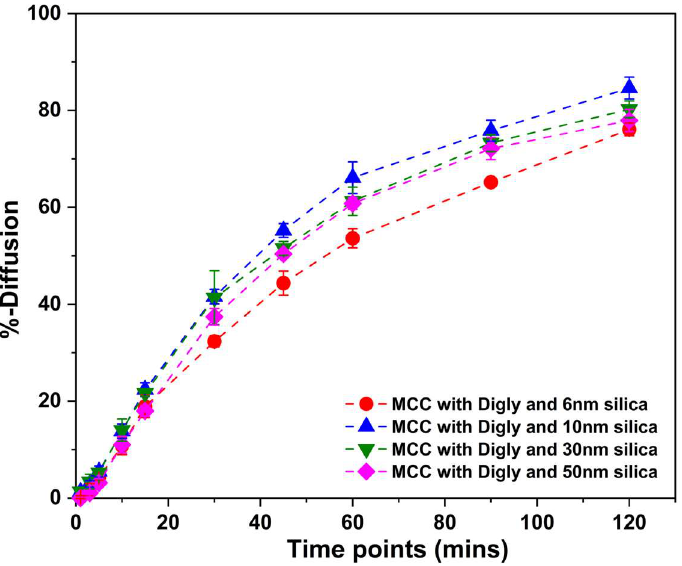
Figure 4. %diffusion of diglycine from the diglycine, silica, and MCC composite tablet compressed at 2.5 kN. The diffusion medium was water; volume = 100 mL; and stirring = 100